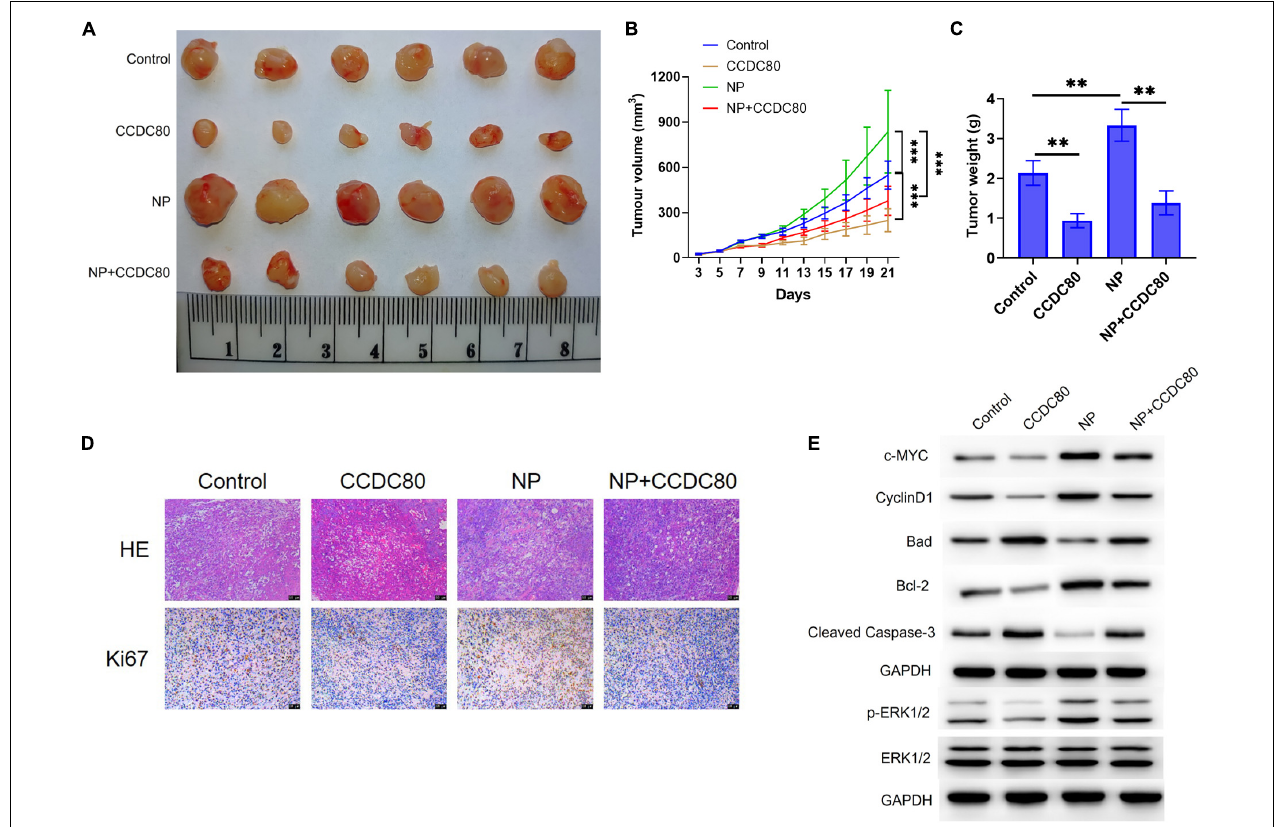
FIGURE 8 | Overexpression of coiled-coil domain containing 80 (CCDC80) suppresses nonylphenol (NP)-induced tumor growth in vivo . (A) Photograph of tumor tissues after treatment. Bar = 50 µ m. (B) The tumor volume measured every 2 days ( n = 6). ∗∗ p < 0.01, ∗∗∗ p < 0.001. (C) The tumor weight measured after resection ( n = 6). ∗∗ p < 0.01. (D) The expression of Ki67 in tumor tissues as detected by hematoxylin-eosin (HE) and immunohistochemistry (IHC) strain. (E) The expression of cell proliferation-related proteins (PCNA, c-MYC, and CyclinD1), cell apoptosis-related proteins (Bcl-2, Bad, and Cleaved Caspase-3), ERK1/2, and p-ERK1/2 in tumor tissues analyzed using western blot